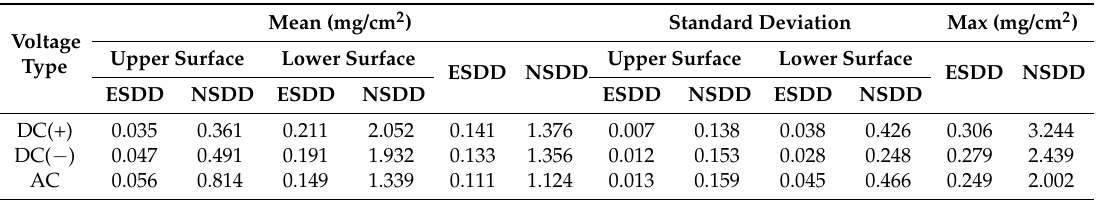
Table 4. The ESDD and NSDD of insulators.